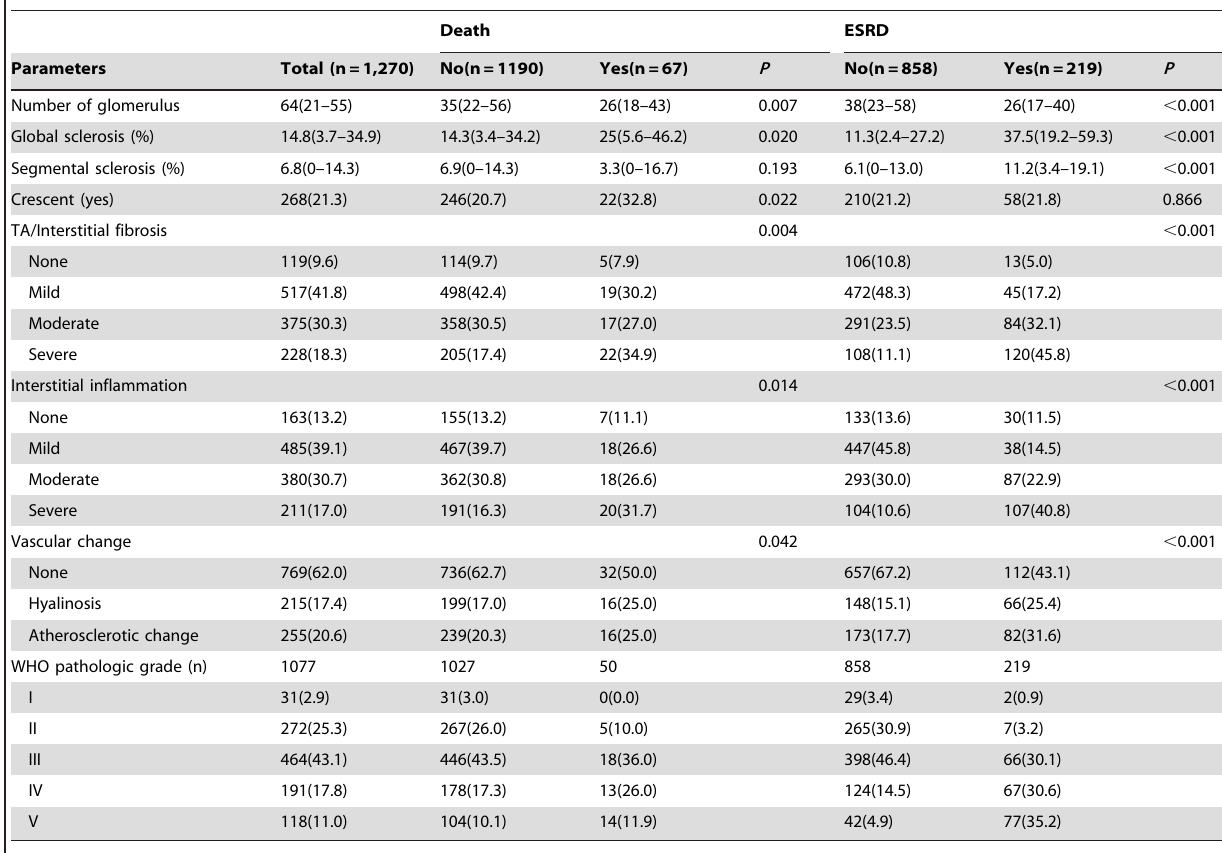
Table 2. Pathologic changes of study